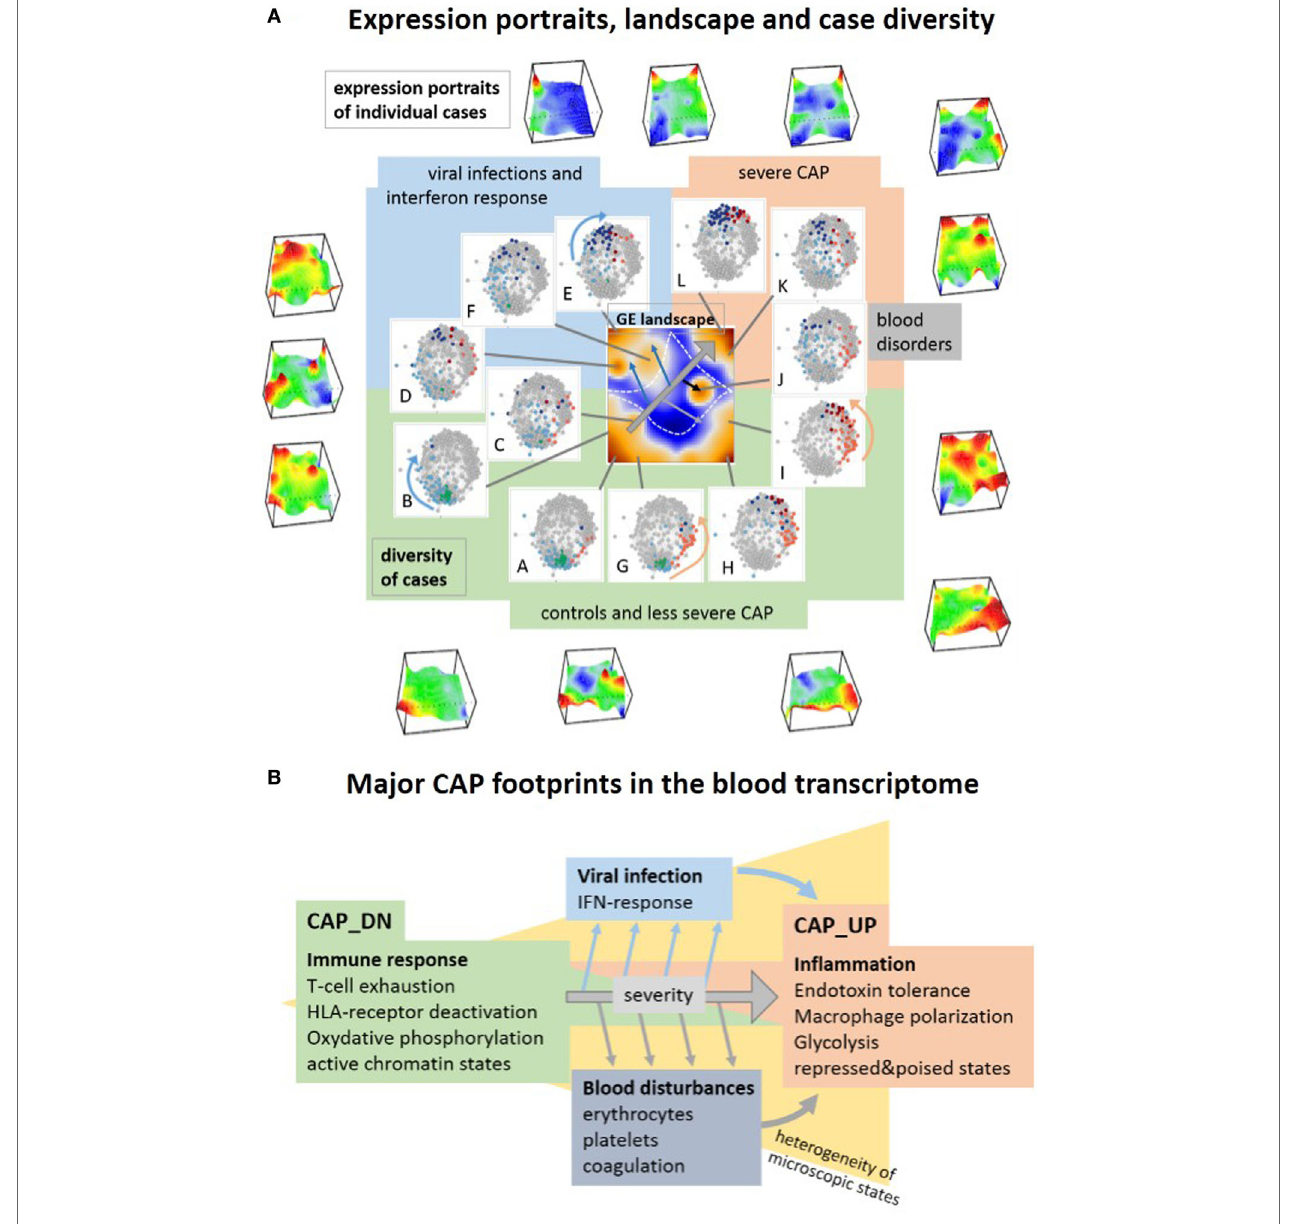
FigUre 10 | Visualization of the transcriptome landscape on three levels (a) , namely “personalized” expression portraits, a “feature” gene expression (GE) landscape and a sample diversity landscape and schematic overview of the major community-acquired pneumonia (CAP) footprints in the blood transcriptome (B) . (a) The portraits show up- and downregulated modules of correlated genes in red and blue, respectively, where the vertical coordinate visualizes the expression and the horizontal one the self organizing maps-mosaic. The GE “feature” landscape summarizes these spots as maroon areas of variant GE (see also Figure 1B ). For each spot A–L, we colored the cases showing this particular spot in the diversity network (see also Figure 1a ). Spot activation associates with groups of samples in the network: increasing severity of CAP activates spots roughly along the arrow in the GE landscape, which in turn associates with cases located in direction of the arrows shown in the similarity